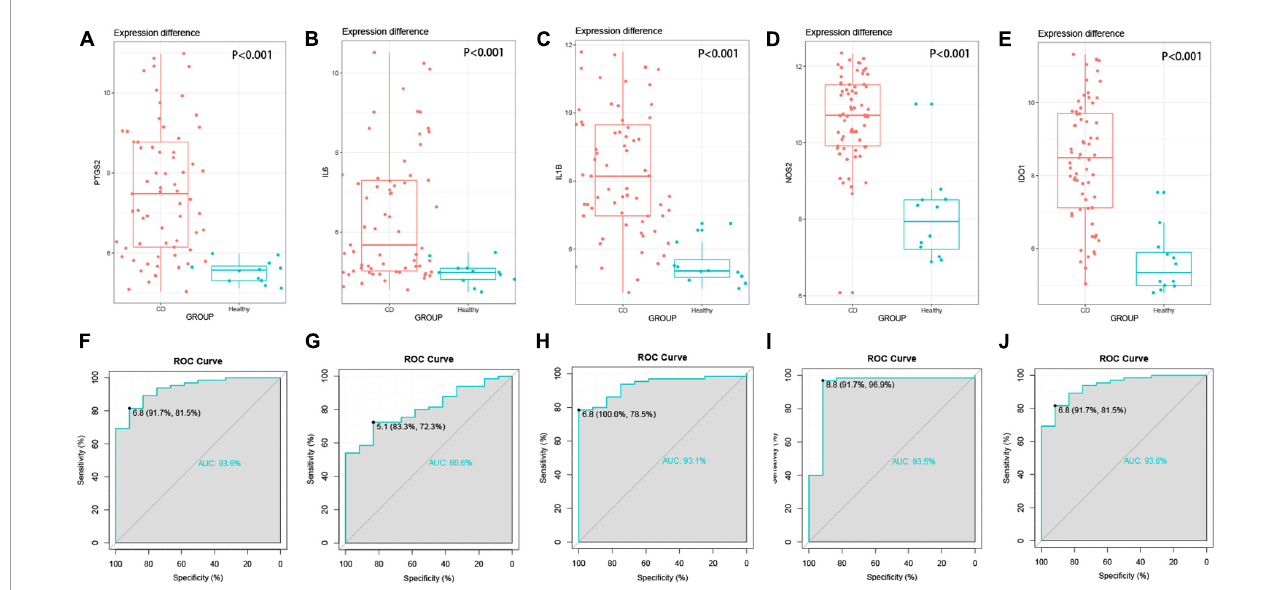
FIGURE5 External validation of hub genes. (A–E) Hub gene expression between disease group and control group, P < 0.001. (A) PTGS2, (B) IL6, (C) IL1B, (D) NOS2, (E) IDO1, (F–J) the ROC curve of the hub gene, the AUC values are all greater than